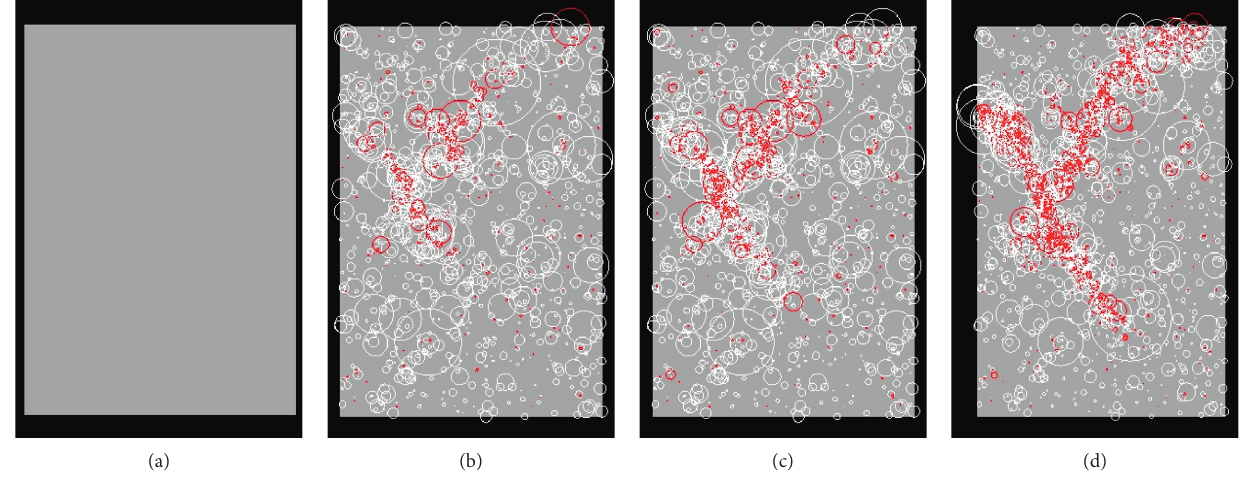
Figure 12: Acoustic emission of rock mass at ratio of height to diameter of 1.5.